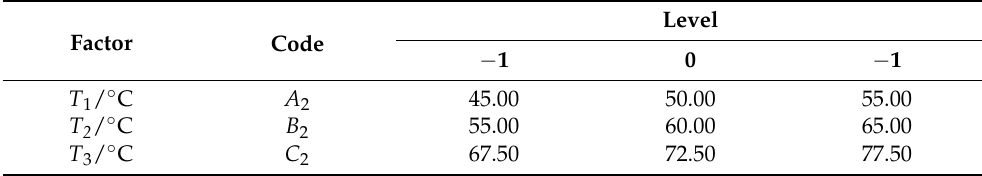
Table 2. Temperature factor codes and